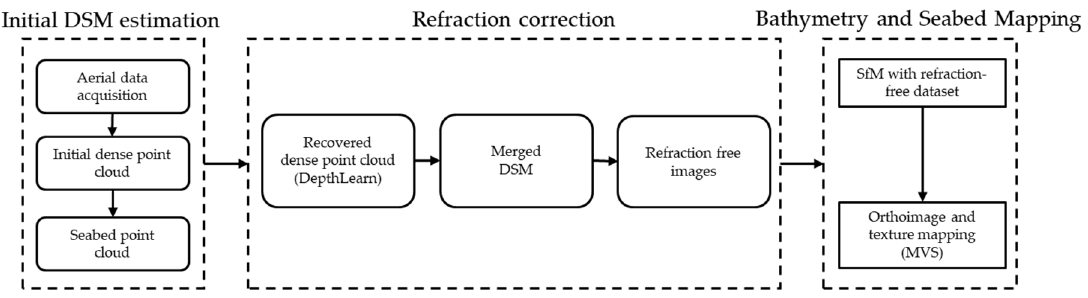
Figure 1. The workflow of the proposed methodology.